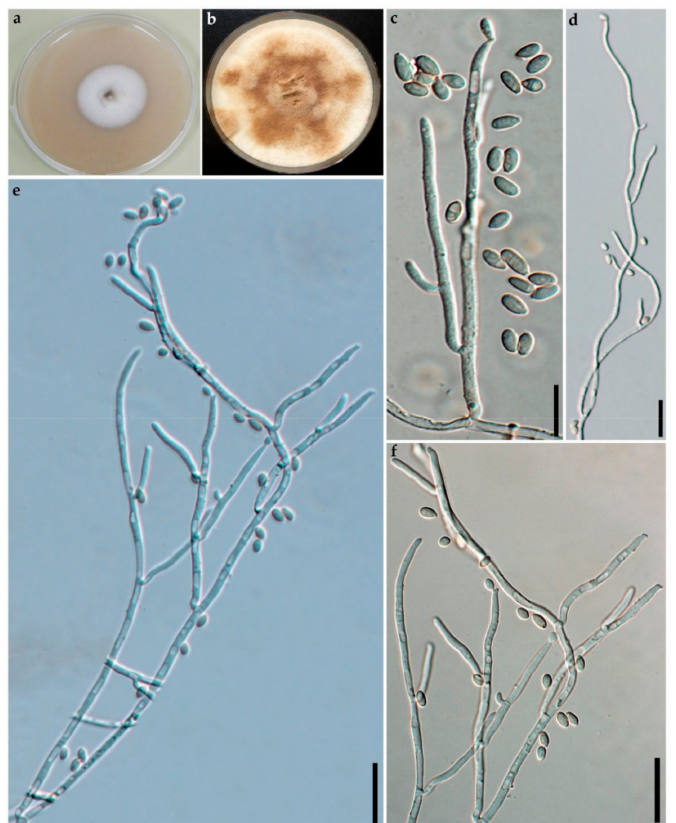
Figure 3. Culture and anamorphic structures of Hypoxylon eurasiaticum (GUM 1597) on OA. ( a,b ) surface of colony after 1 and 8 weeks of incubation (respectively left to right); ( c – f ) general view of anamorph structure with virgariella-like branching patterns, conidiogenous cells, immature and mature conidia. Scales bars set as ( c – f ) 20 µ